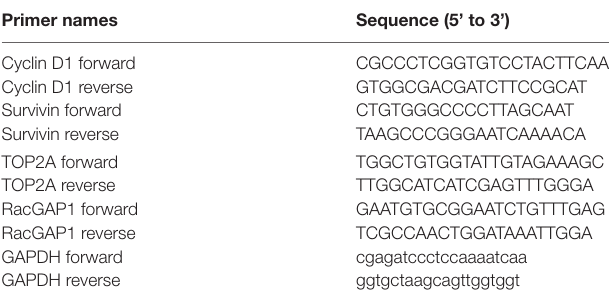
TABLE A1 | Primers sequences of genes expressing in primary breast cancer